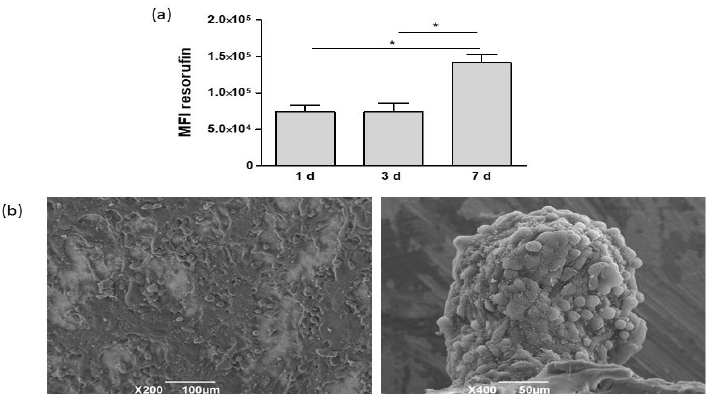
Figure 3. ( a ) Cell viability at various time points from seeding. MFI: mean fluorescence intensity. * p < 0.05 vs corresponding cultures grown on PCL scaffolds. ( b ) SEM micrographs of HCC1954 cell cultures on PCL at 7 days from seeding. Cells completely covered electrospun PCL (left panel, bar: 100 µm) and formed spheroids (right panel, bar: 50 µm).